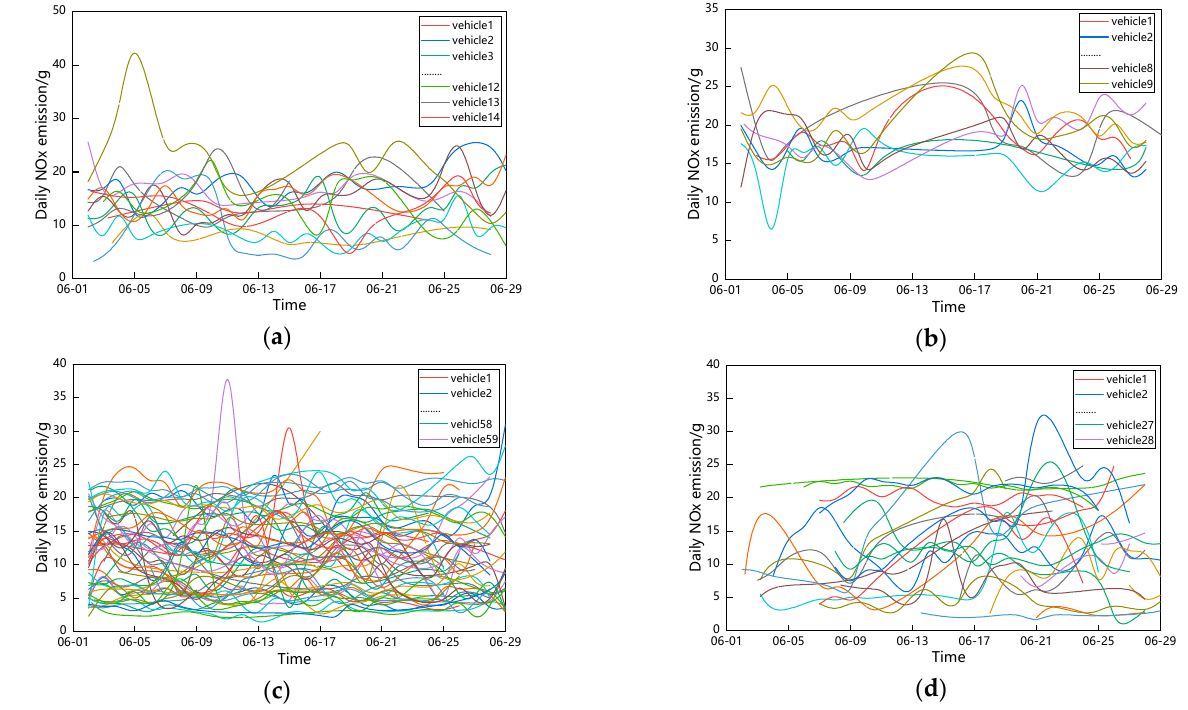
Figure 6. Refueling vehicles NOx emission at legal stations in June. ( a ) Legal gas station No. 1; ( b ) Legal gas station No. 2; ( c ) Legal gas station No. 3; ( d ) Legal gas station No. 4.